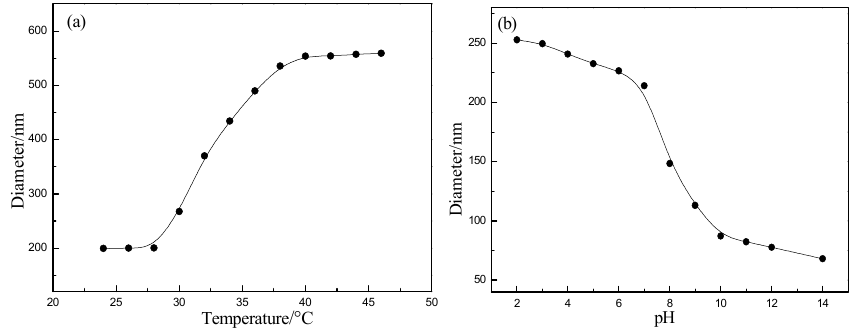
Figure 5. The aggregate particle diameters in P2 aqueous solution as a function of temperature ( a ) and solution pH ( b ) at 25 °C (0.5 mg·mL − 1 ).